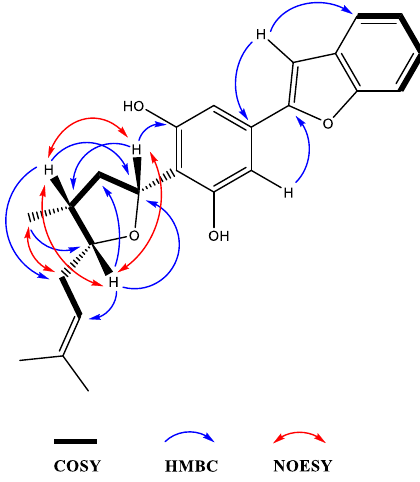
Figure 3. Key 2D NMR COSY, HMBC, and NOESY correlations of compound 1a.